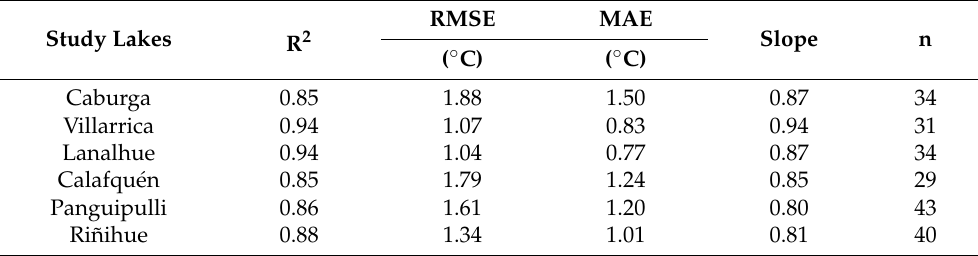
Table 2. Validated results for the comparison between MODIS LSWT and in situ LSWT for the six lakes that presented p -values ≤